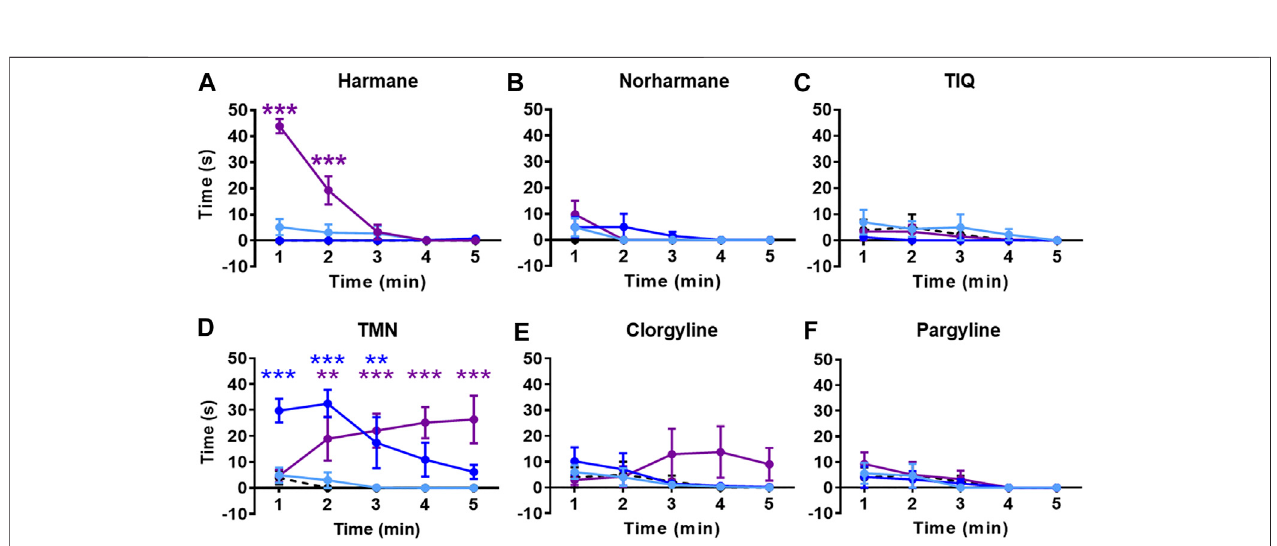
FIGURE 5 | Effects of MAO inhibitors on freezing time. Total freezing time during the NTT is presented for (A) harmane (1, 3, and 10 mg/L) (B) norharmane (0.3, 1, and 3 mg/L) (C) TIQ(10,30,and100 mg/L) (D) TMN(3,10,and30 mg/L) (E) clorgyline(10,30,and100 mg/L),and (F) pargyline(10,30,and100 mg/L).Blackdashed line (cid:1) vehicle control; light blue (cid:1) lowest concentration; blue (cid:1) middle concentration; purple (cid:1) highest concentration. The sample size is detailed in the legends for Figures 3 , 4 . Data are expressed as mean ± SEM. ** p < 0.01; *** p < 0.001. Abbreviations: NTT (cid:1) novel tank test; TIQ (cid:1) 1.2,3,4-tetrahydroisoquinoline; TMN (cid:1)